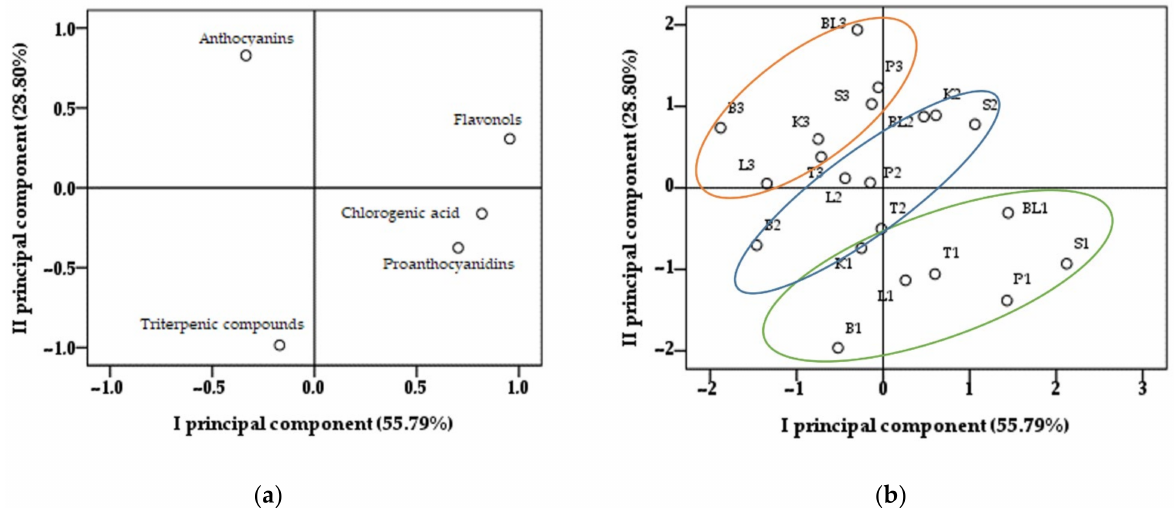
Figure 5. Principal component analysis loading ( a ) and score ( b ) plots of different cranberry sam- ples. ( b ) The samples of cultivars collected on 16 August: 1BL—’Ben Lear’, 1B—‘Bergman’,